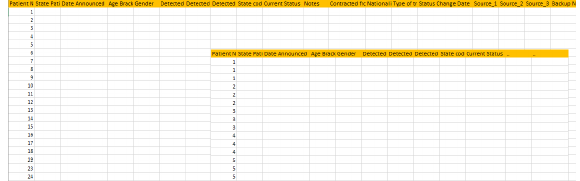
Figure 5. Example of splitting COVID-19 Data (CSV files)